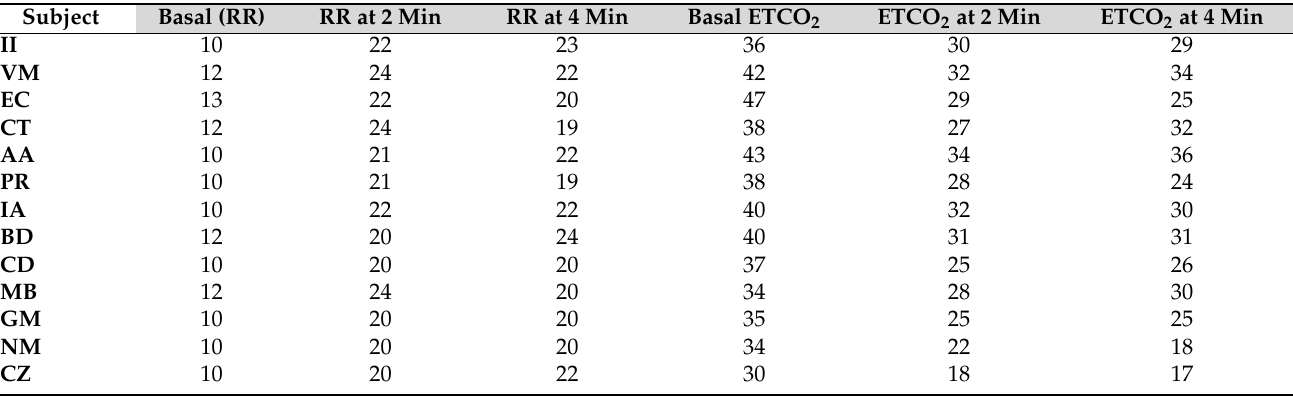
Table A1. The Recorded Parameters for All the Volunteers Enrolled in the Study: RR—Respiratory Rate, ETCO 2 —End-Tidal CO 2